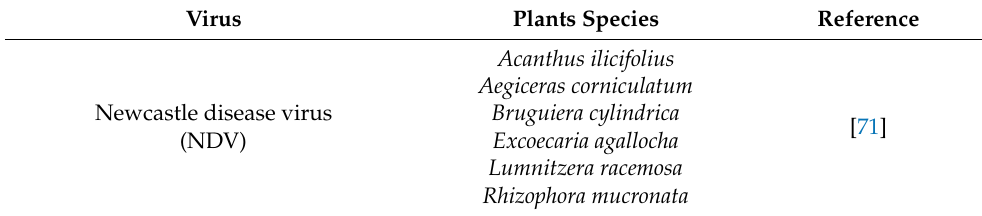
Table 2. Antiviral effects associated with extracts of halophyte plants. Virus Plants Species